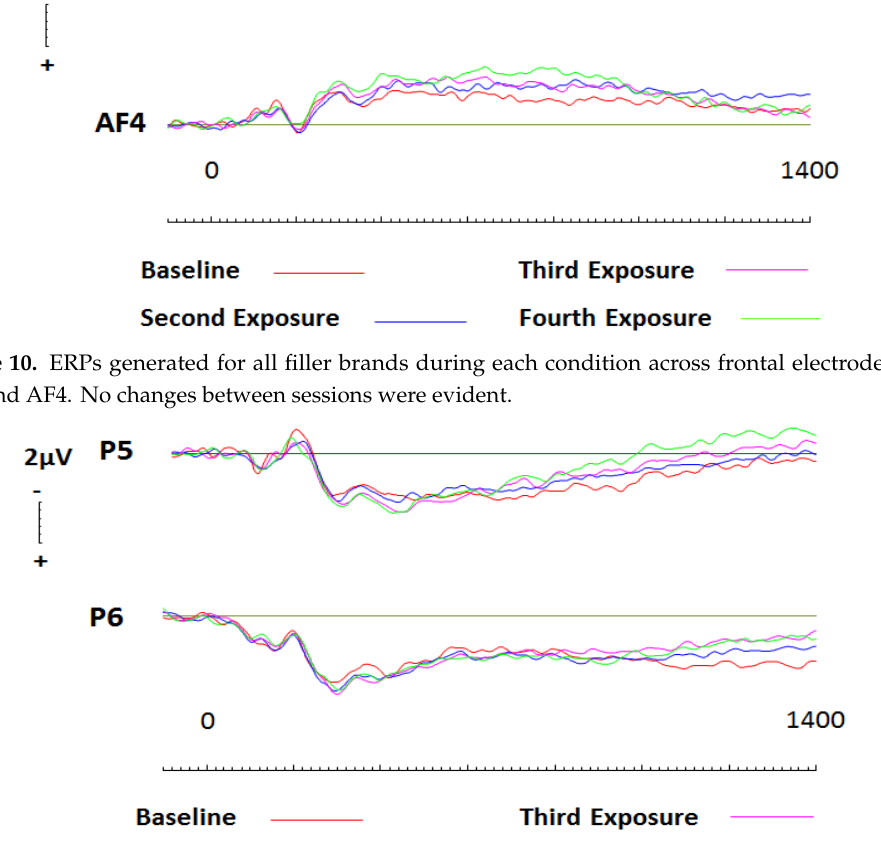
Figure 11. ERPs generated for all filler brands during each condition across parietal electrode sites P5 and P6. No changes between sessions were evident.